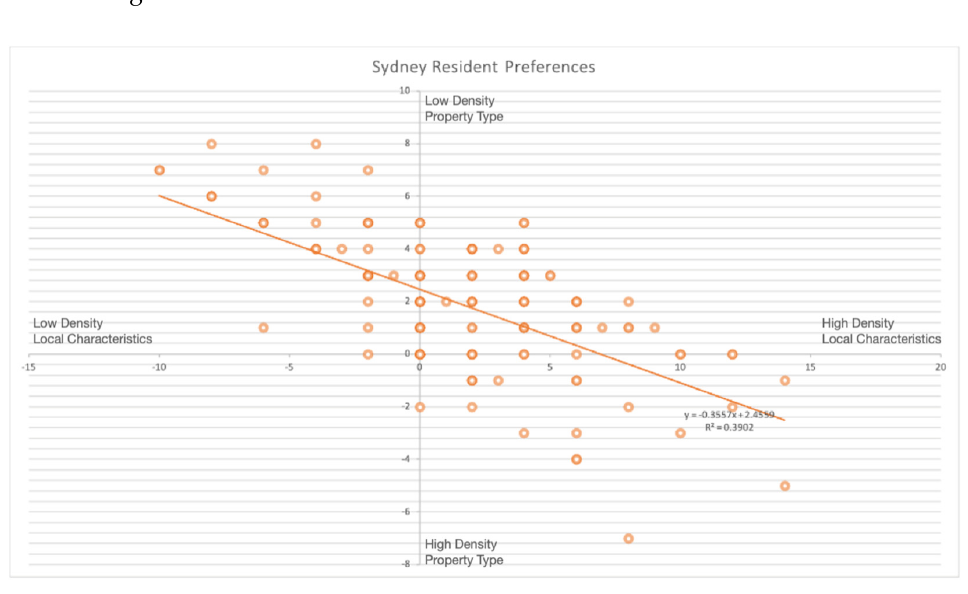
Figure 6. Sydney Resident Preferences.